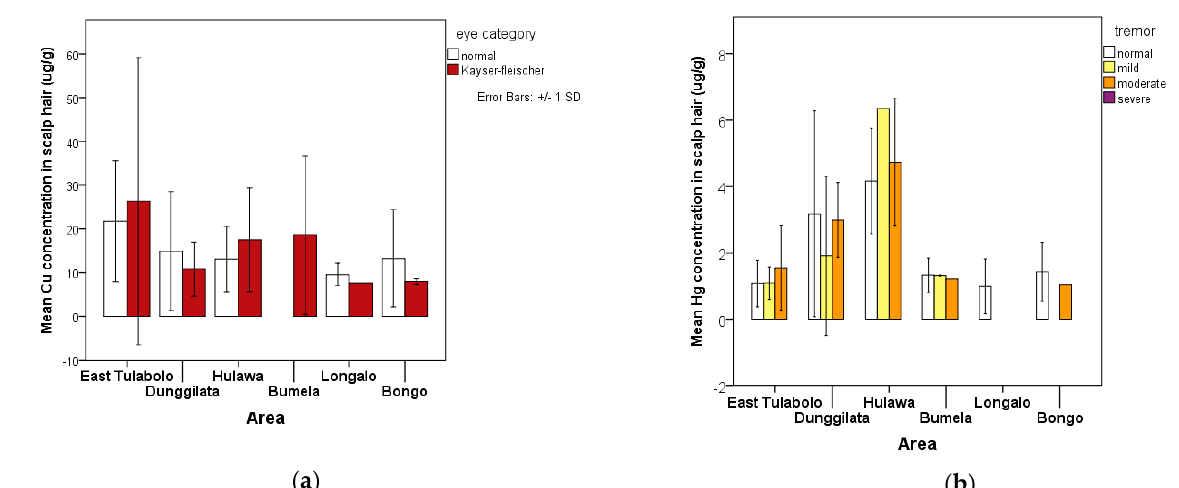
Figure 3. Graph depicting the relationship between the presence of health signs and symptoms related to heavy metal exposure and the accumulation of these potentially toxic elements in scalp hair: ( a ) average accumulation of copper (Cu) in human scalp hair per area shows a high number in the East Tulabolo area, and is almost as common in all areas; ( b ) average accumulation of mercury (Hg) in scalp hair per area shows a high number in the Hulawa and Dunggilata areas.